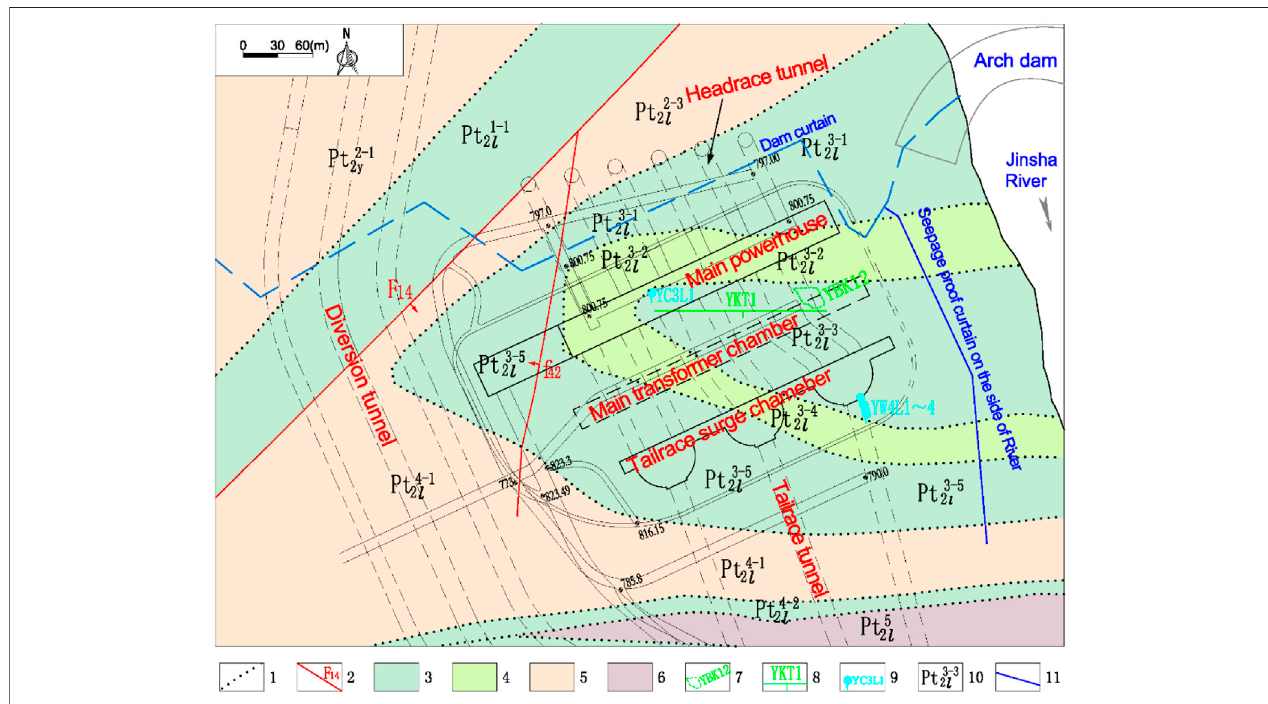
FIGURE 2 | Geological map of the underground powerhouse on the right bank at EL800 m (1) stratigraphic boundary, (2) fault, (3) moderate karst rock formation, (4) weak karst rock formation, (5) slight karst rock formation, (6) non-karst rock formation, (7) karst cave, (8) corrosion discontinuity, (9) spring, (10) strata code, (11) curtain.